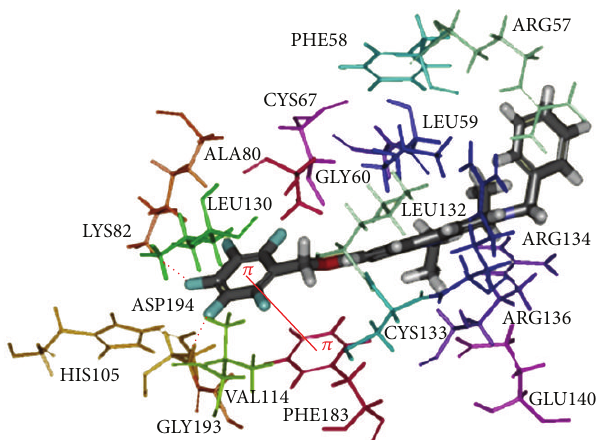
Figure 4: Docked binding mode of compound 57 into active site of the PLK1 (PDB code 2WOB). The protein key residues that form the main interactions with the different structural units of the inhibitor are labeled. Hydrogen bonds are represented as red dots. The 𝜋 - 𝜋 stacking interaction between PHE183 and compound 57 is shown as an orange